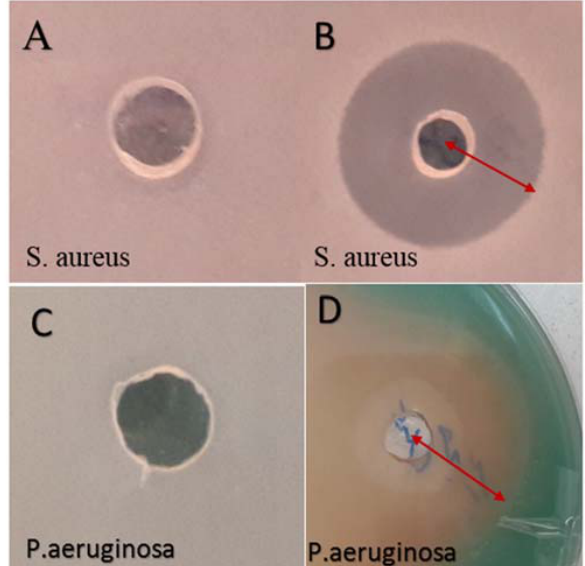
Fig. 5. The antibacterial activity of (A,C) aloe vera and (B,D) honey in the presence of S. aureus and P. aeruginosa